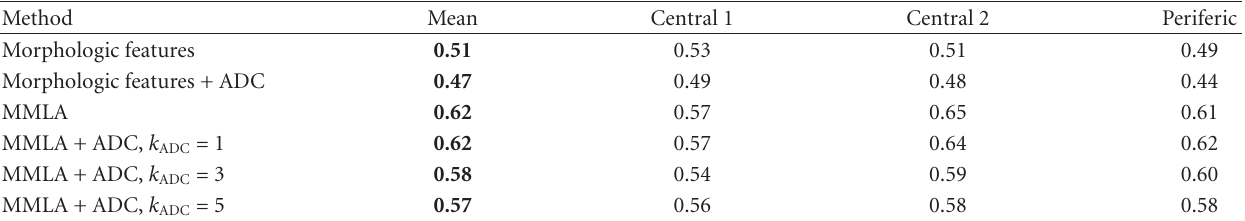
Table 1: Silhouette analysis scores describing cluster compactness and separation for the whole ROI and for each relevant region for the kinetic features and the multimodal lesion assessment (MMLA) methods (the higher the